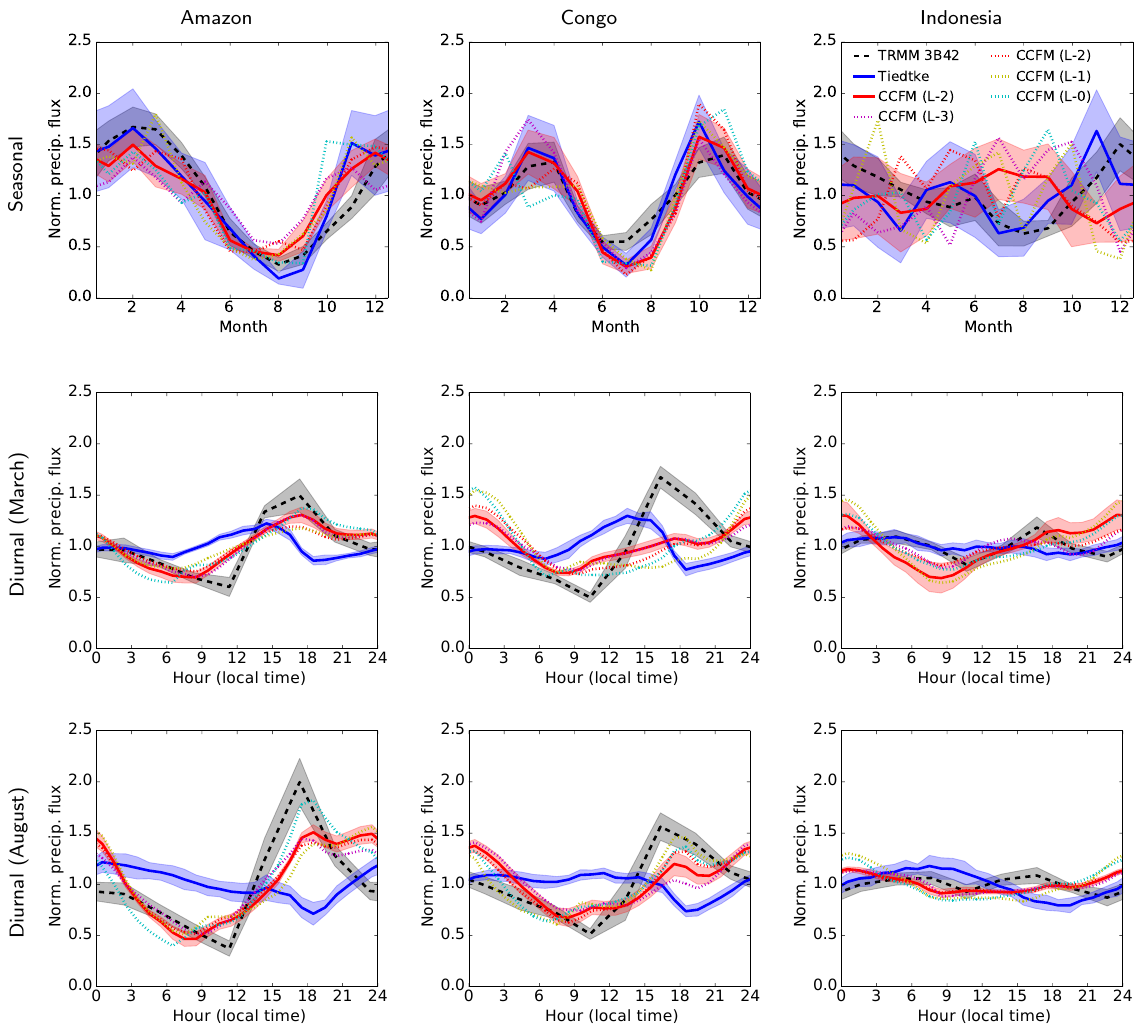
Figure 10. Normalised seasonal (top) and diurnal (below) cycles of precipitation in the Amazon (left), Congo (centre) and Indonesia (right) regions from a 10-year overlap between the TRMM 3B42 product and AMIP-type simulations using ECHAM–HAM with Tiedtke–Nordeng and CCFM (L − 2) convection. The shaded regions indicate the interannual standard deviation of each data set. The dotted lines show the cycles from 1-year simulations using alternative CCFM configurations. The diurnal cycles are in the local time of each region, and are shown for March and August; the full set of months is included as Figs.